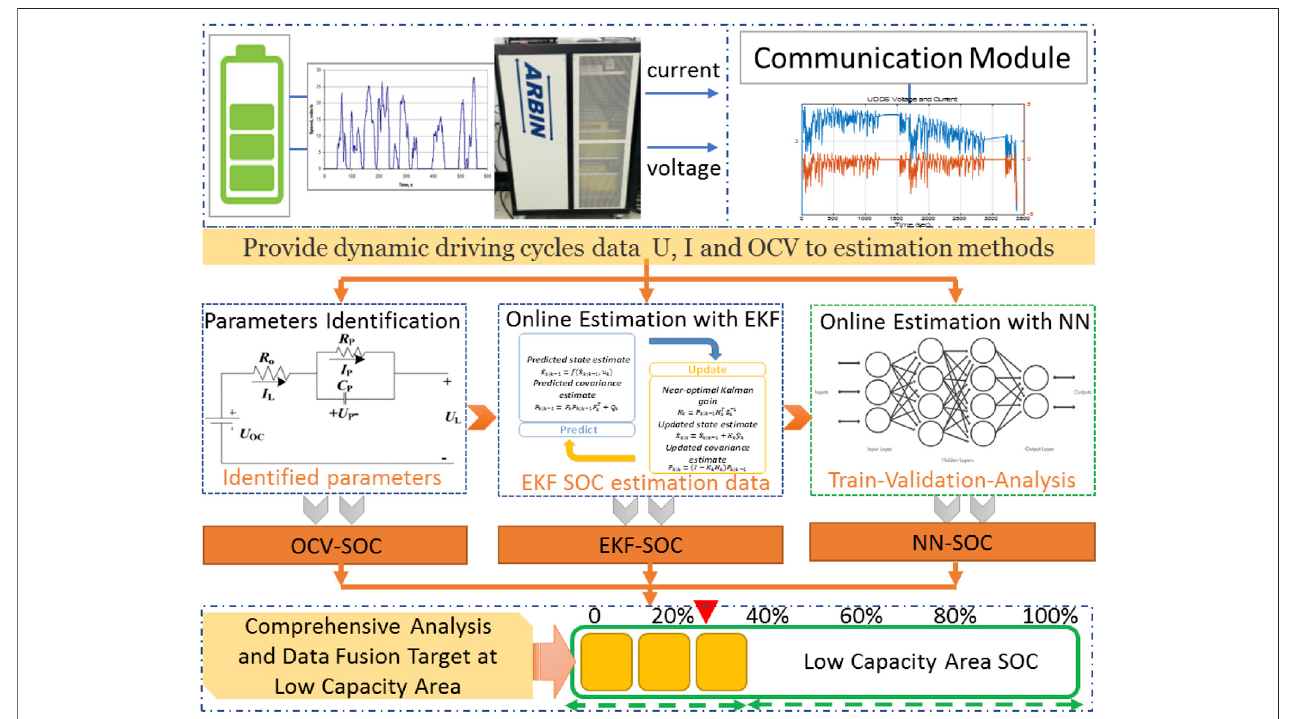
FIGURE 4 | Estimation method